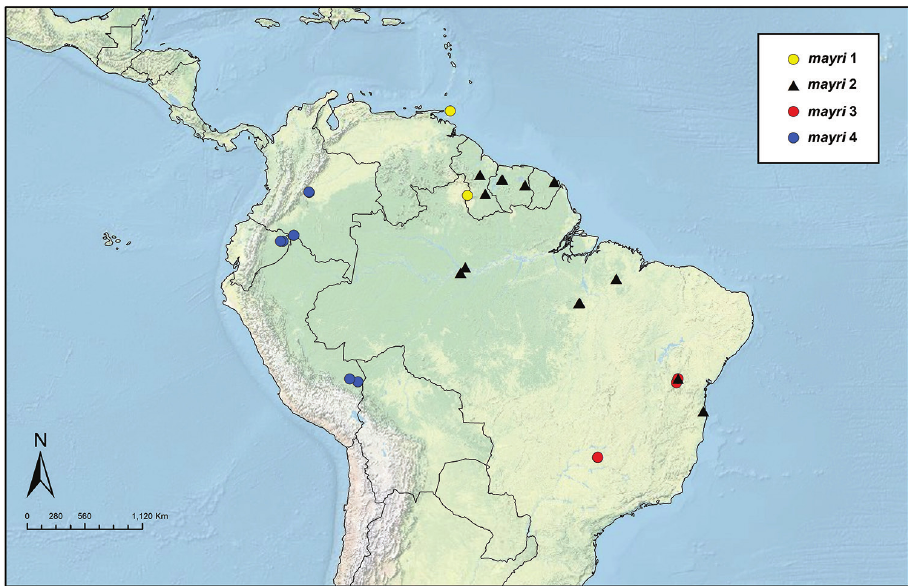
Figure 42. Distribution map of S. mayri populations. This map is based on the subset of S. mayri sam- ples for which molecular data (either UCE or COI) were obtained. Detailed specimen locality data are included in Suppl. material 2: Table